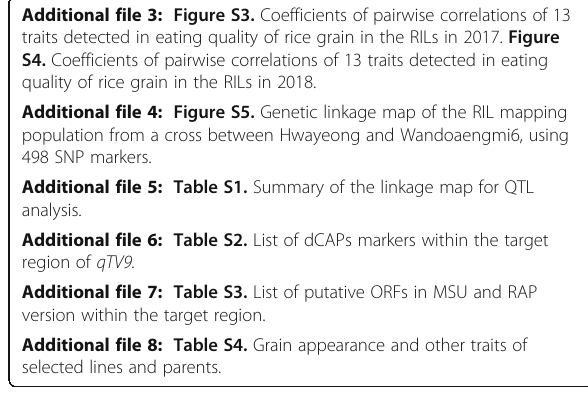
498 SNP markers. Additional file 5: Table S1. Summary of the linkage map for QTL